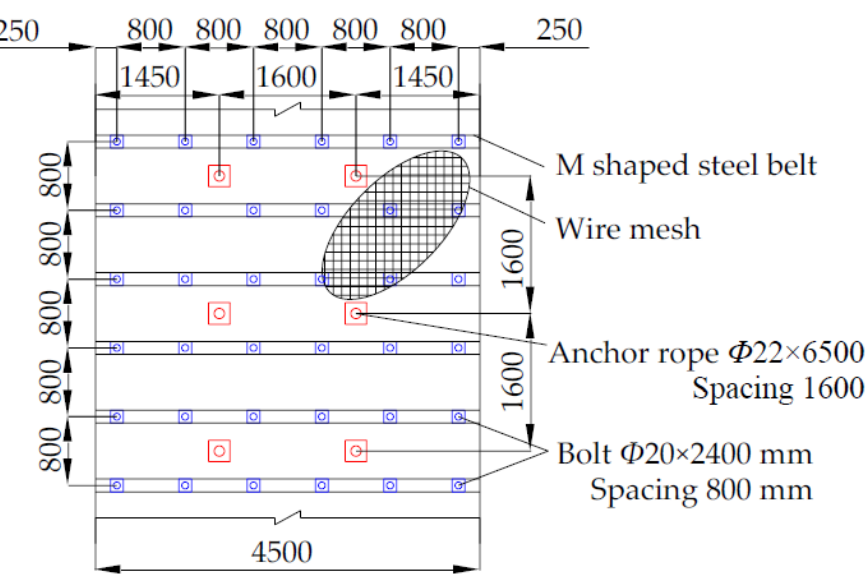
Figure 18. Section of the return-air roadway support in working face 3204.